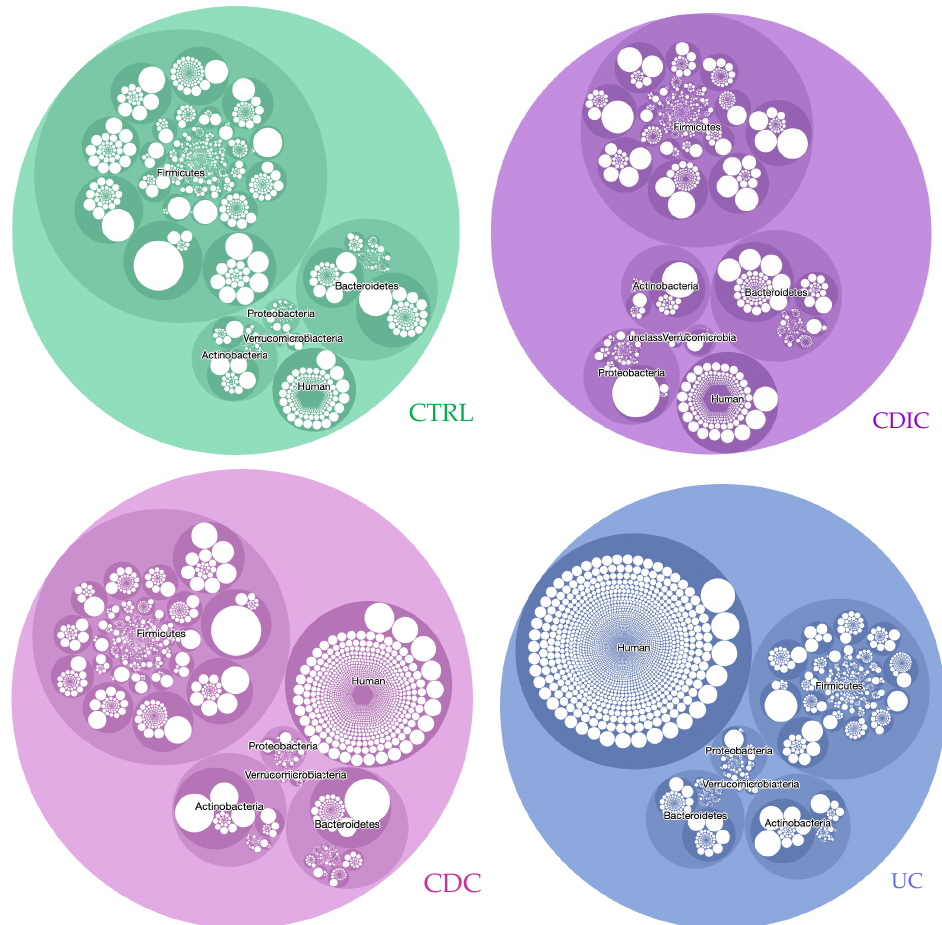
Figure 3. CirclepackeR graphs illustrating the intensity of true activities in the envelope-enriched fractions of the different taxonomic groups in CTRL and IBD microbiomes. Abundances of protein subgroups (computed as the sum of the spectral counts of their specific peptides) were summed within each taxonomic species, which were packed into genera and phyla. For readability, only the five main phyla, Actinobacteria , Bacteroidetes , Firmicutes , Proteobacteria , and Verrucomicrobia , plus unclassified bacteria and human proteins, are represented. See Figure S2a–d for interactive detailed inspection. Abbreviations and headcounts of patient groups are those detailed in legend of Figure